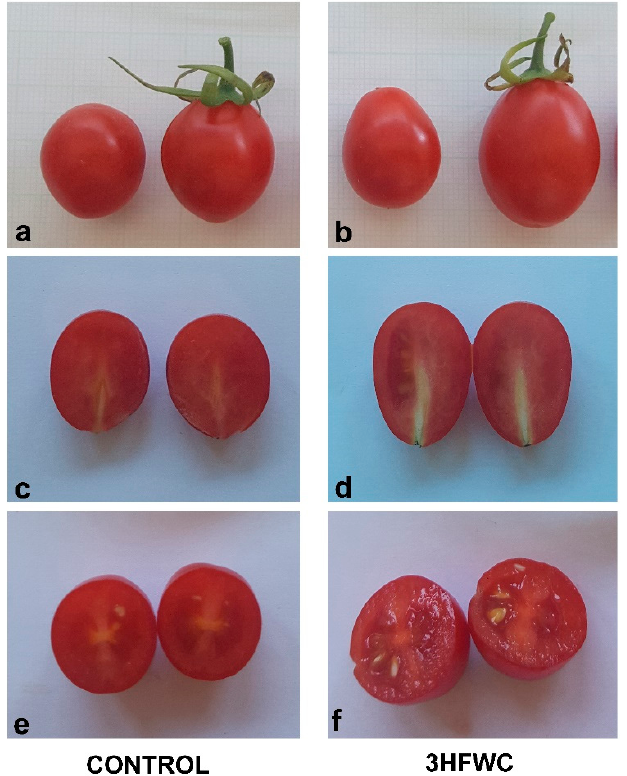
Figure 8. The morphological analysis of cherry tomato fruits derived after exposure to 3HFWC nanosubstance. ( a , b ) Cherry tomato fruits of control ( a ) and 3HFWC-exposed plants ( b ); ( c , d ) Longitudinal section of fruits of control ( c ) and 3HFWC-exposed plants ( d ); ( e , f ) Transversal section of control ( e ) and 3HFWC nanosubstance-exposed plants ( f ).